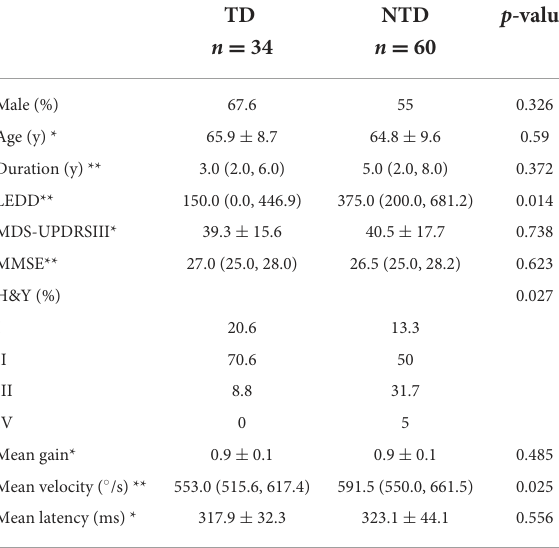
TABLE 4 Characteristics of PD patients with normal latency and prolonged latency.